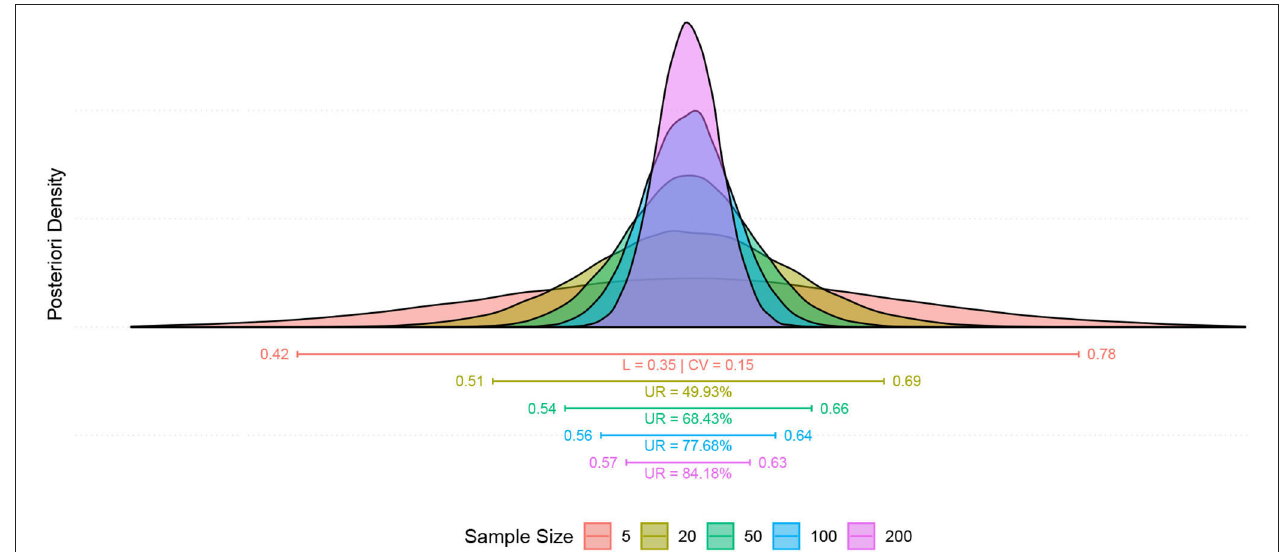
FIGURE 14 | Illustration (in a simulated context) of the progressive uncertainty reduction due to increased sample size. The first segment (in red) highlights the length of the credibility interval (L) and the coefficient of variation of the a posteriori distribution (CV), in the following segments the magnitude of UR for each stage stands out ( n = 20,50,100,200) when compared to the uncertainty we had in the first study ( n = 5).